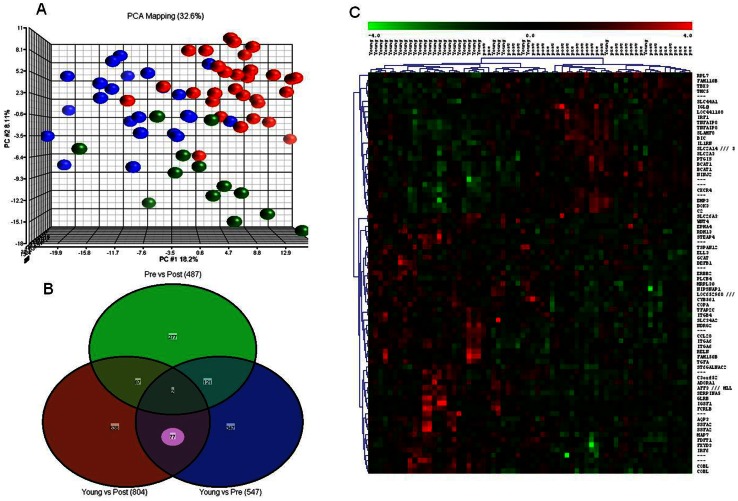
Identification of genes specific to young women with breast cancer.(A)The unsupervised principal component analysis (PCA) separated samples according to their age group hence supporting the conclusion that there is a distinct gene expression changes associated with the tumor in different age groups. The red spheres refer to young patients (≤45; Young), green for 45–55 years (Pre), and blue for ≥55 years (Post). (B) Venn diagram characterizing differential gene expression between and specific to different age groups. The red circle (left) shows the 804 probes that are differentially expressed between Young and Post; 77 probes (corresponding to 63 genes) were found to be specific to tumor in young women only (circled in light pink). (C) Unsupervised two-dimensional hierarchical clustering of all tumor samples based on their gene expression similarity using young-age-specific 77 probes was performed using Pearson’s correlation with average linkage clustering. The hierarchical clustering revealed clear pattern of genes deregulation defining two main transcriptome clusters, one was mainly composed primarily younger cases, and one was composed of primarily elderly women. Samples are denoted in columns and genes are denoted in rows (gene symbols listed on the right). The expression level of each gene across the samples is scaled to [−4, 4] interval. These mapped expression levels are depicted using a color scale as shown at the bottom of the figure, as such highly expressed genes are indicated in red, intermediate in black, and weakly expressed in green.